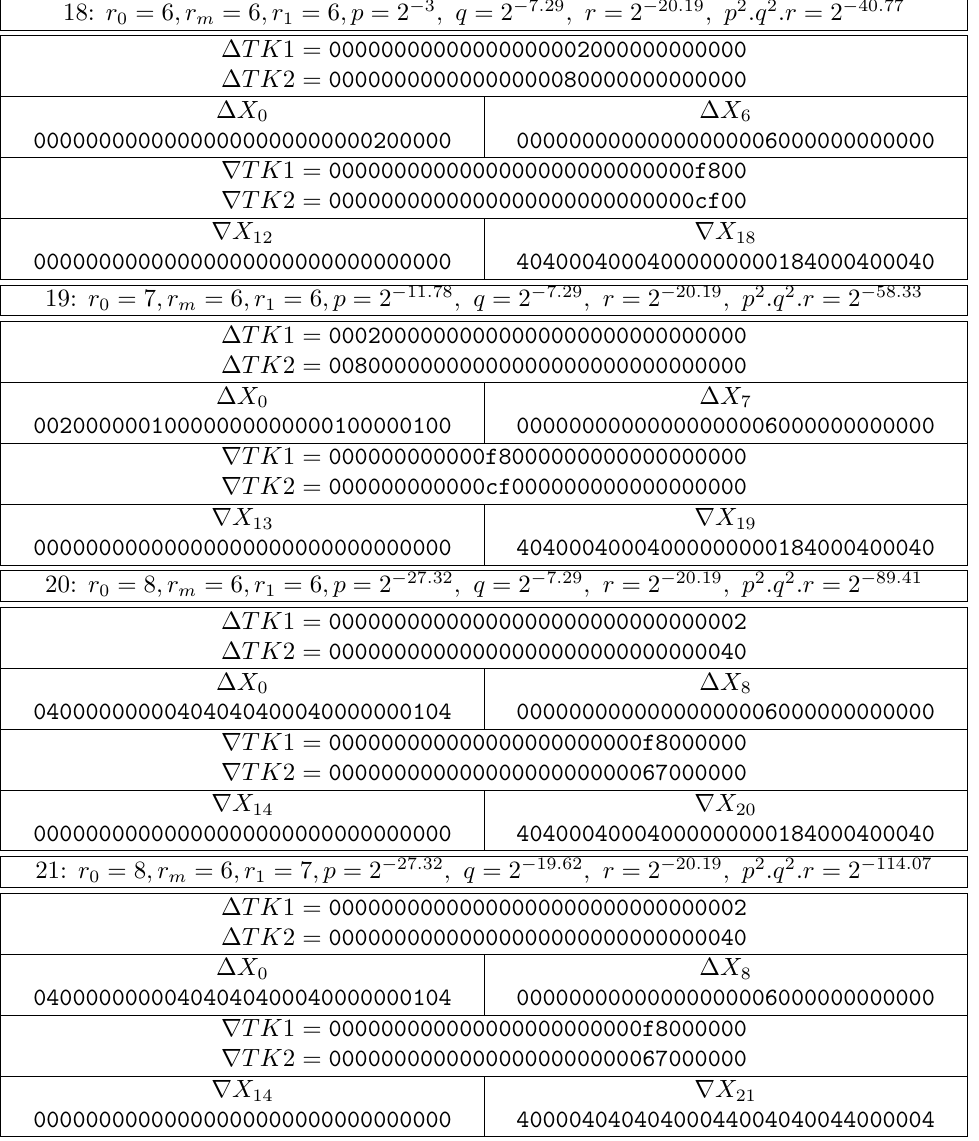
Table 21: Boomerang distinguisher II for 18, 19, 20 and 21 rounds of SKINNY -128-256